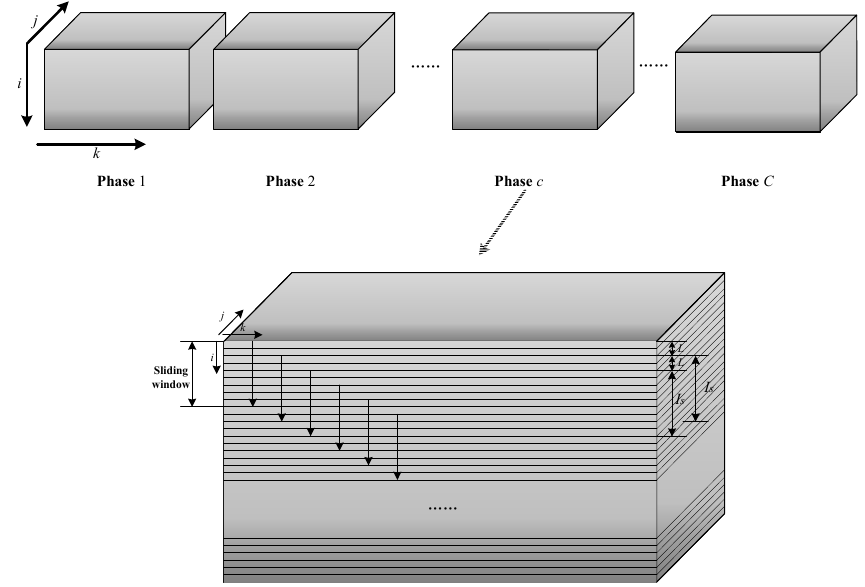
Figure 2. Development of sliding window in batch direction. The 3D data matrix, , is expanded into a 2D matrix,